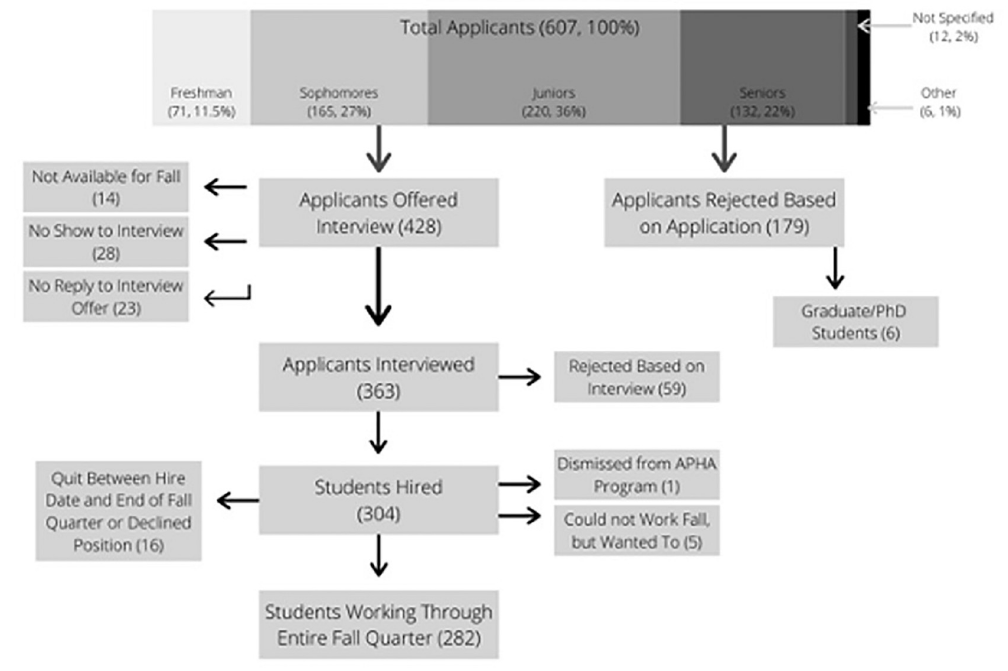
Fig 1. Screening and selection process